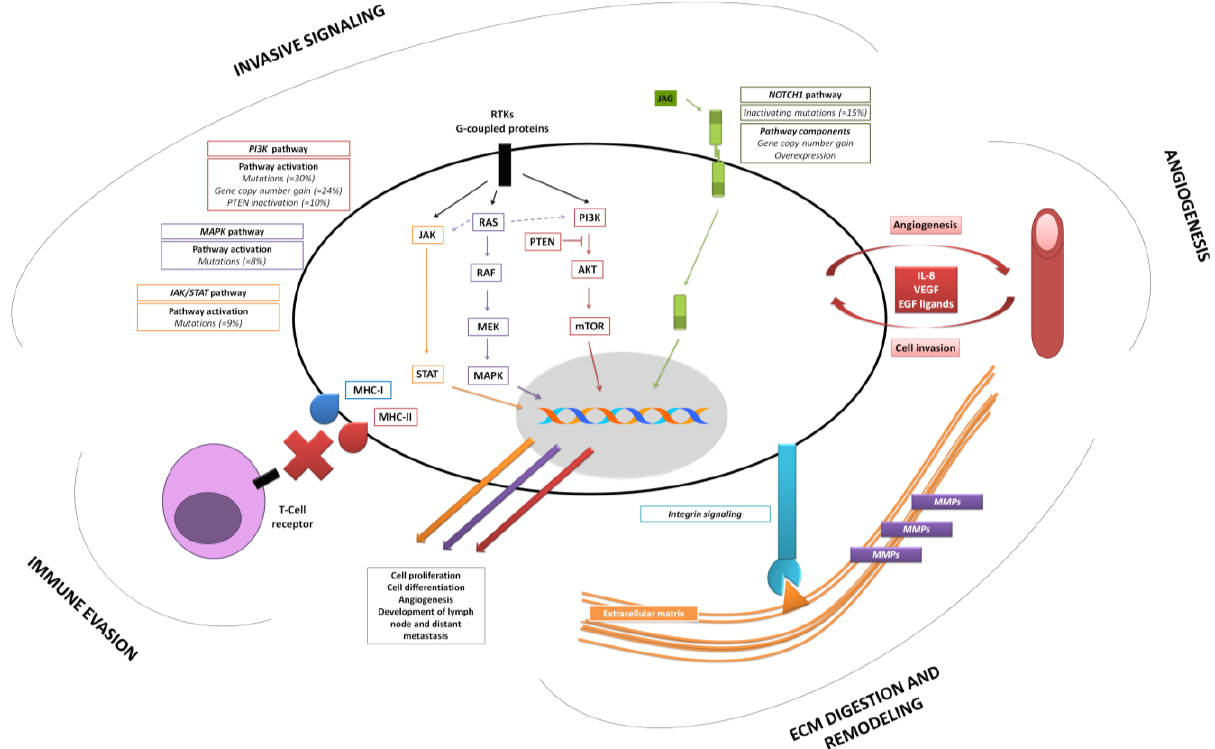
Figure 1. Most relevant mechanisms of cell invasion outlined by high-throughput profiling studies in head and neck squamous cell carcinoma (HNSCC).